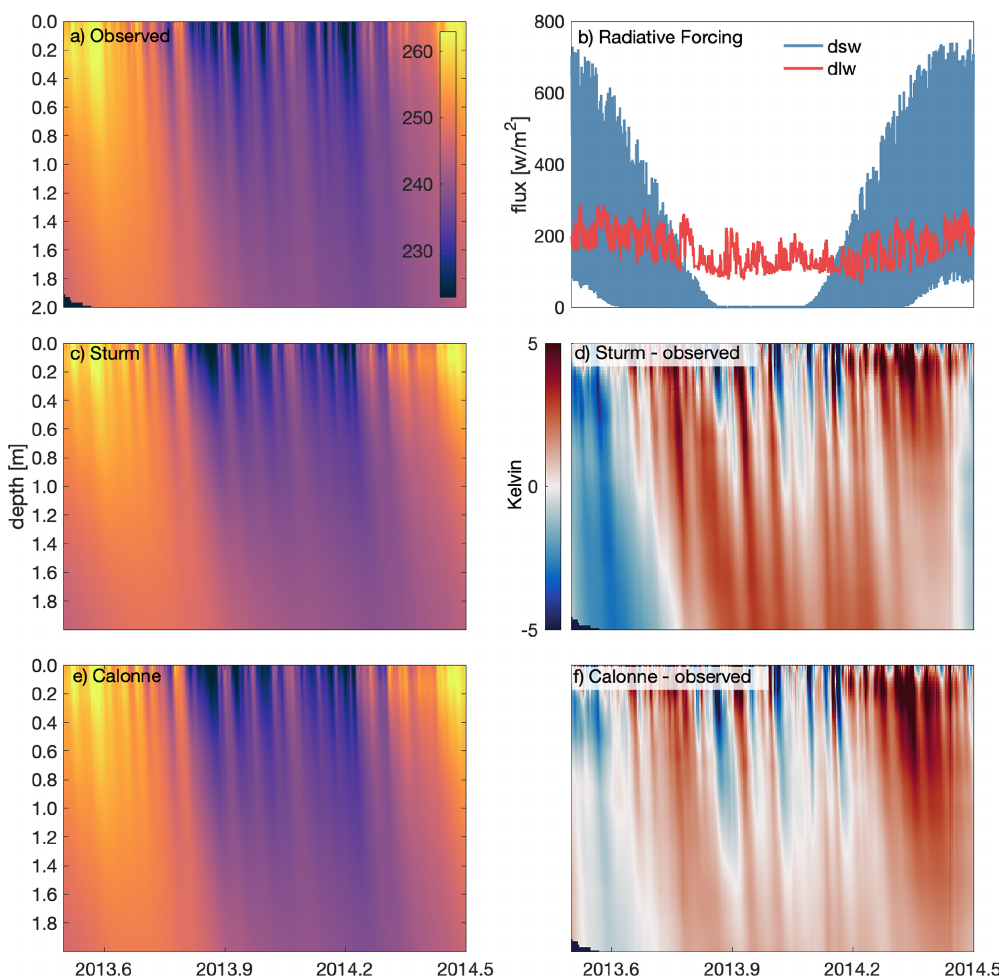
Figure 12. Observed and modeled daily near-surface (upper 2m) temperatures for Summit Station, Greenland (72.580 ◦ N and 38.459 ◦ W), from July 2013 to June 2014. Temperature profiles from (a) observations (Miller et al., 2017), (c) modeled using GEMB and Sturm et al. (1997) thermal conductivity, and (e) modeled using GEMB and Calonne et al. (2011) thermal conductivity. (b) Observed downward shortwave (dsw) and longwave (dlw) radiation provided for context. Differences between temperature profiles for (d) GEMB–Sturm and observations and for (f) GEMB–Calonne and observations. Note: all GEMB simulations are forced with RACMO model output (see Ta- ble 1), and therefore modeled temperature differences relative to observations are due to errors in forcing, model parameterizations, and